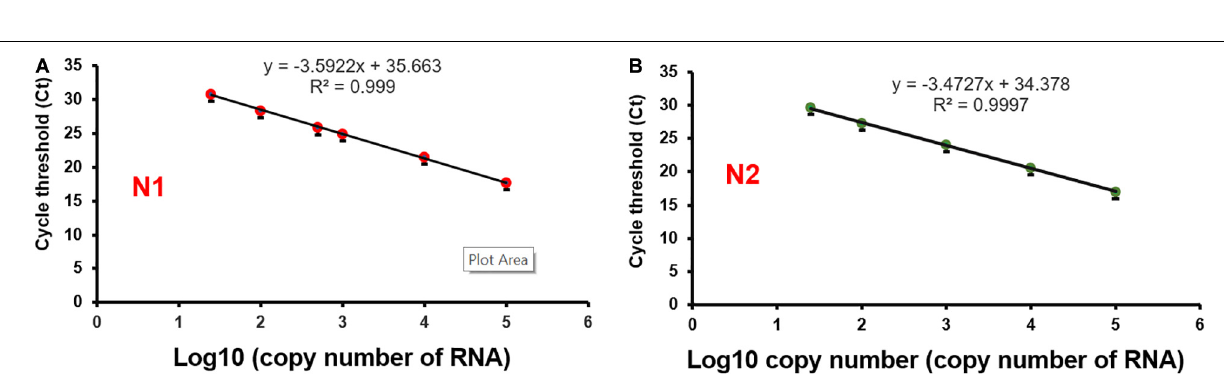
FIGURE 2 | Limit of detection of ultrafast one-step qRT-PCR assay. SARS-Cov-2 synthetic RNA genome was used as a model sample. RNA templates were series diluted in the range of 25–1 × 10 5 copies. Ultrafast one-step qRT-PCR assay detects both N1 (A) and N2 (B) regions of the nucleocapsid gene of SARS-CoV-2.